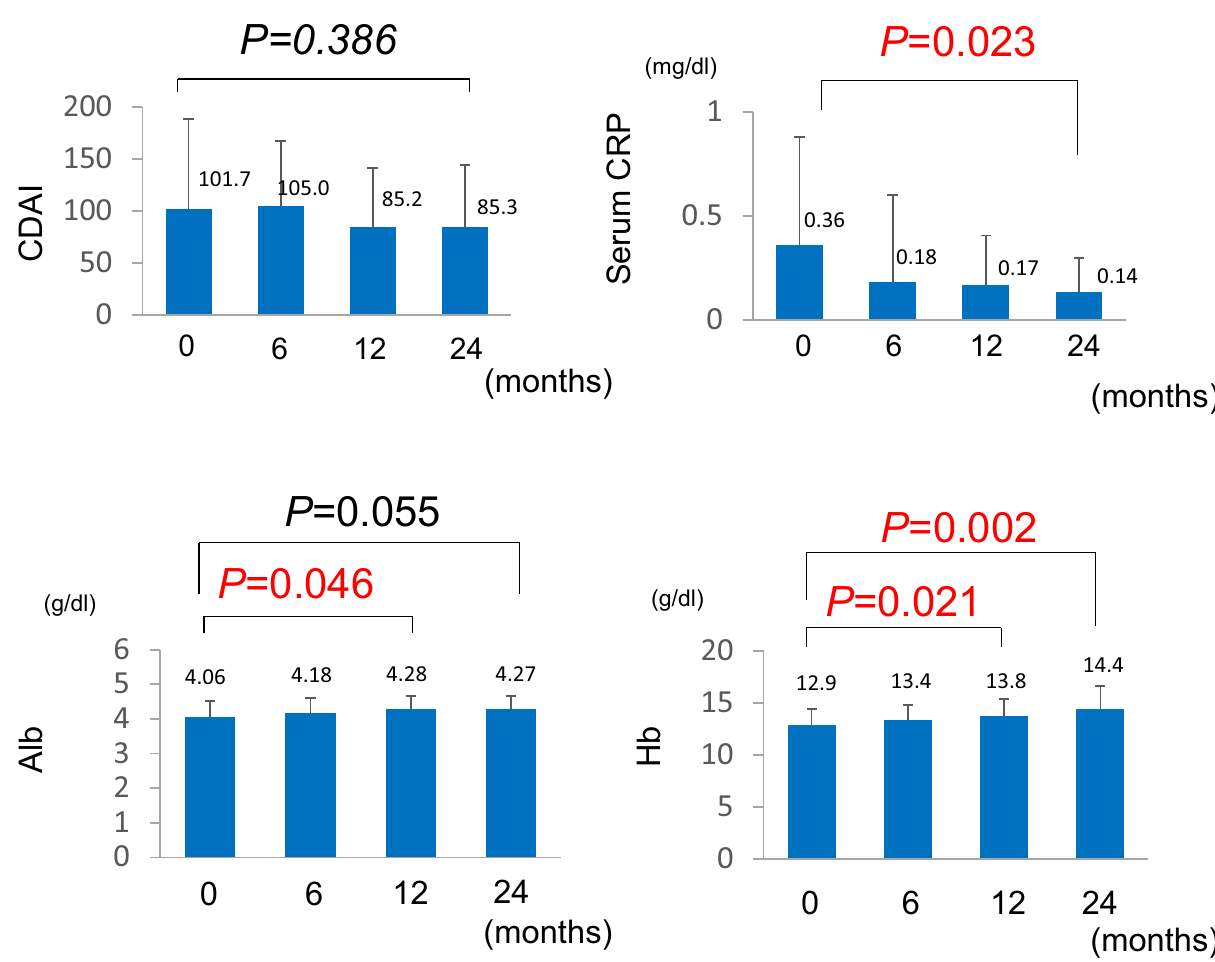
Figure 3. Two-year changes in CDAI and levels of CRP, Alb, and Hb in the continuous treatment group after changing to mesalazine granules. CDAI Crohn’s Disease Activity Index, CRP C-reactive protein, Alb albumin, Hb